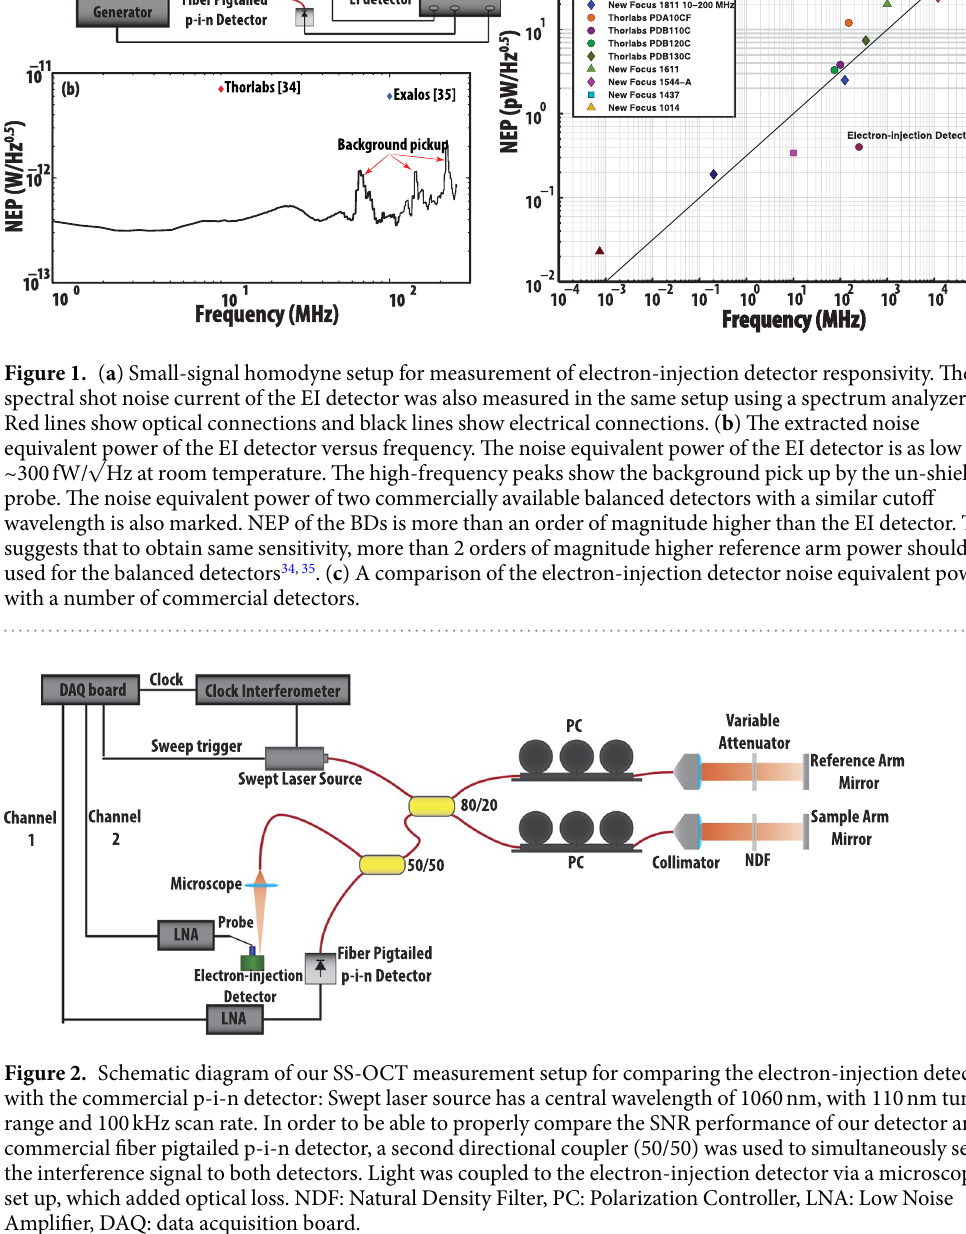
The interference between the reference arm and sample arm signals is detected with the photodetector. In order to properly compare the SNR performance of the electron-injection detector and a commercial p-i-n detec- tor, we used a second directional coupler (splitting ratio 50/50) to simultaneously send the interference signal to both devices. Light was coupled to the electron-injection detector via a microscope set up with ~1.6 dB opti- cal loss. The p-i-n detector was fiber pigtailed, shielded in a metallic box, and had a coaxial cable connection. Polarization controllers (PCs) were used to account for the polarization mismatch and improved the shape and the peak height of the interference envelope. Outputs of the p-i-n and the EI detectors were amplified simultane- ously using voltage amplifiers. Electronic band pass filtering was implemented to improve the SNR. The signals were then digitized using a data acquisition board (DAQ). In our setup, the input referred noise of the amplifiers, dominated the quantization noise of the DAQ. The key parameters defining the system performance (see “Methods” section, equation (6), for details) were experimentally measured and presented in Table 1 for both EI and p-i-n detectors.